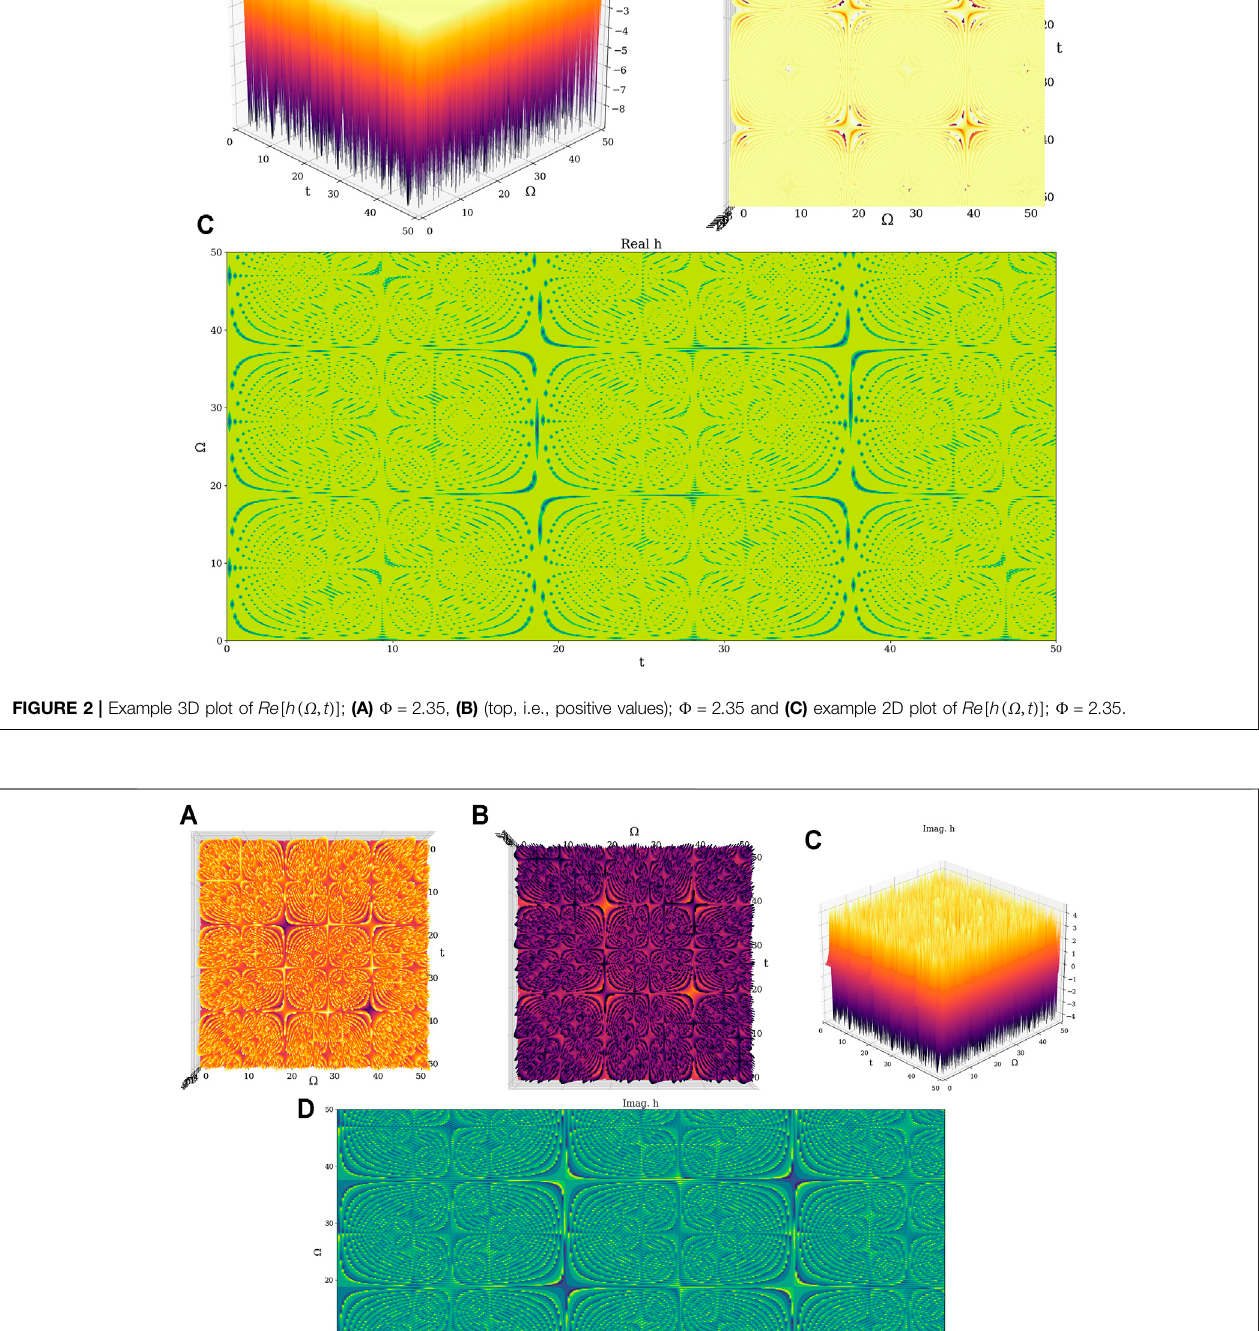
Frontiers in Earth Science |